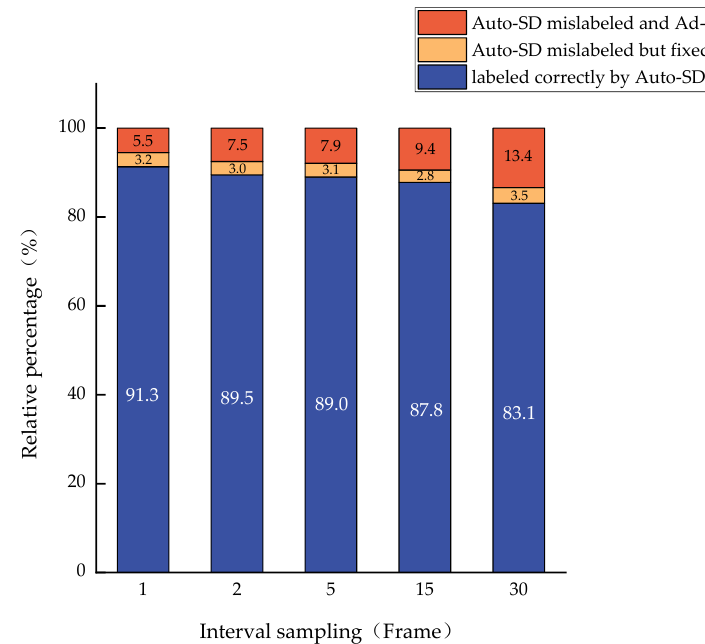
Figure 10. Comparison of the generation results of Auto-SD and Ad-EDB.